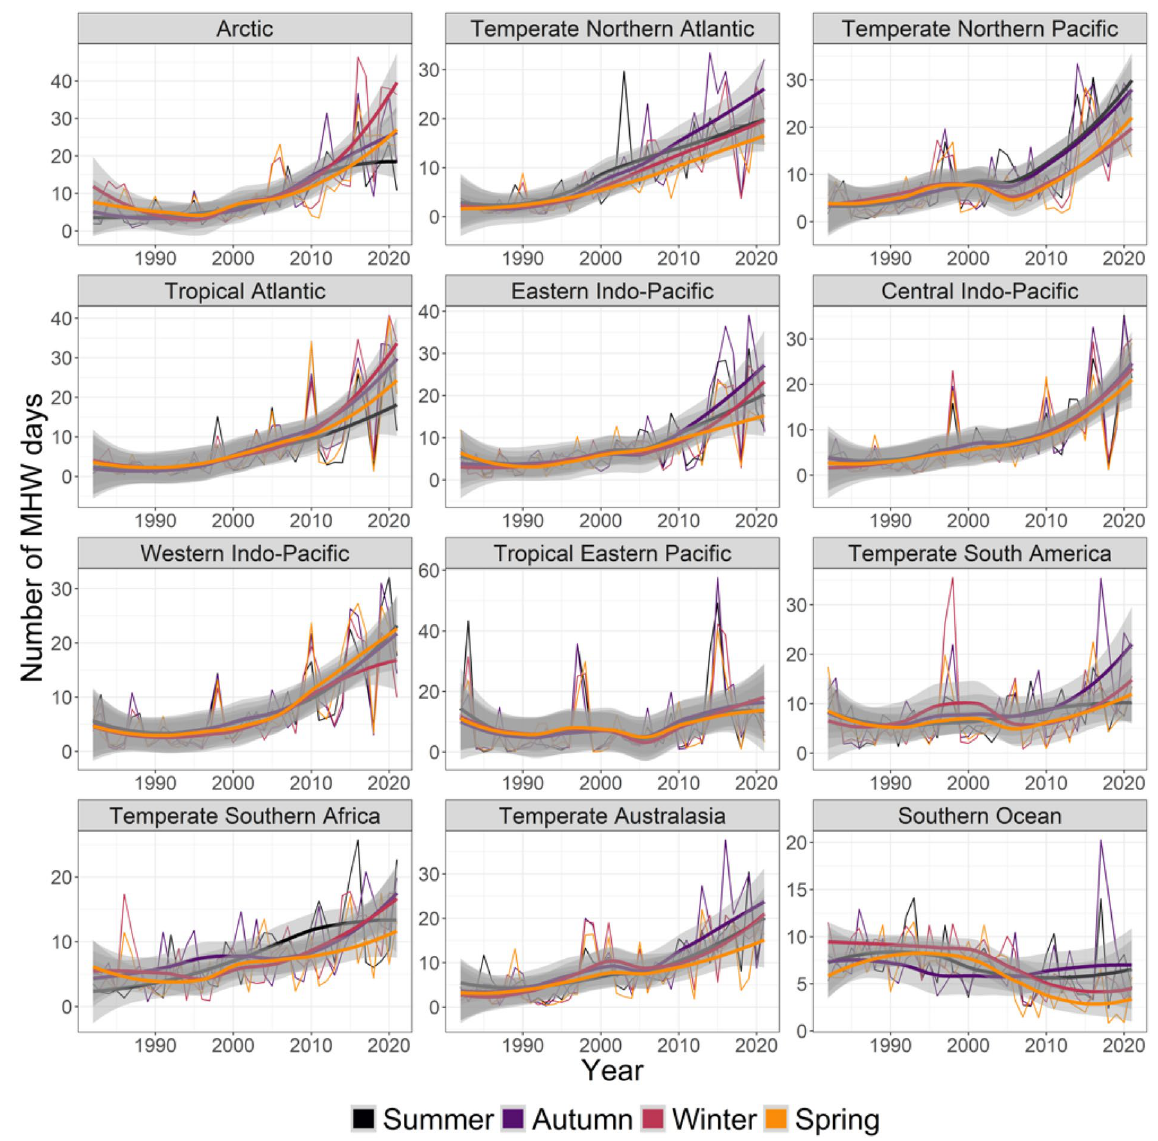
Figure 3. Seasonal trends from 1982 to 2021 in yearly- and pixel-averaged marine heatwave days per coastal realm and season. See Fig. 2 caption for more details and Table S4 for specific trendlines, p values and break point